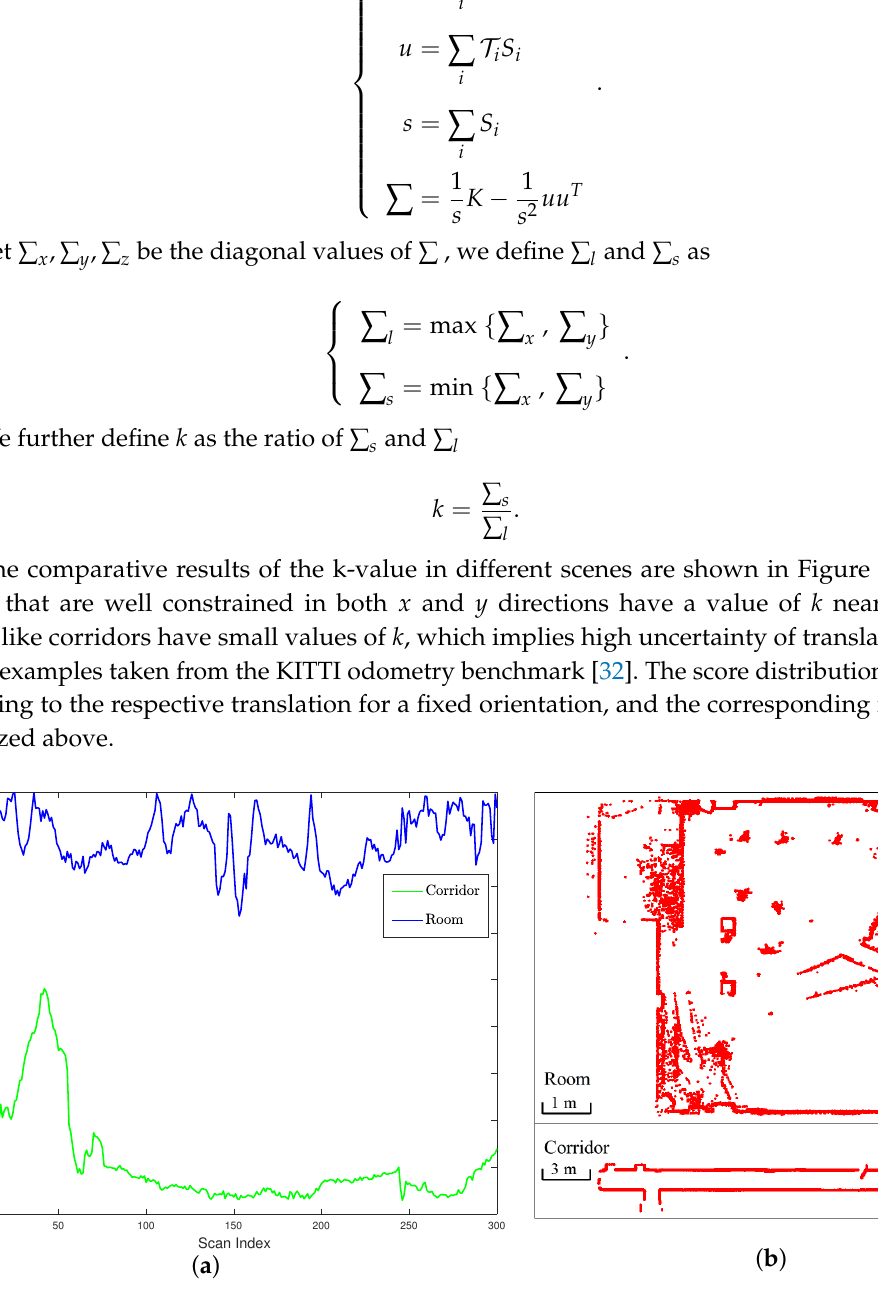
Figure 3. The comparative results of the k-value in different scenes. ( a ) The k-value in two typical scenes. ( b ) The corresponding lidar scan